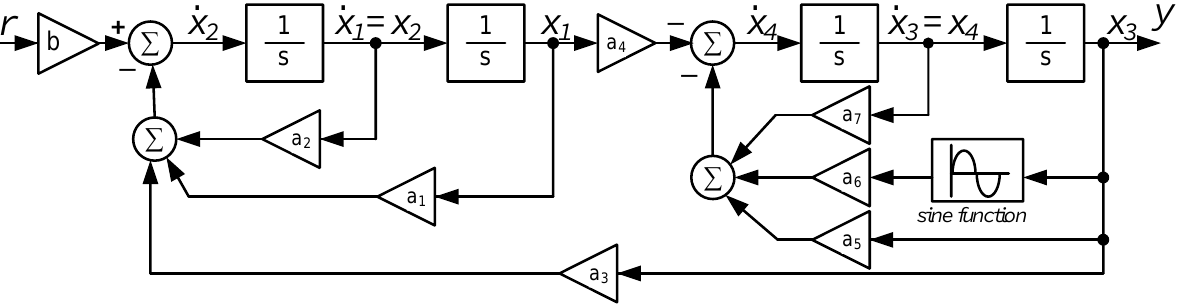
Figure 3. Block diagram of the hybrid soft leg with rigid links and a flexible joint (spring). The system has both linear and nonlinear feedback.